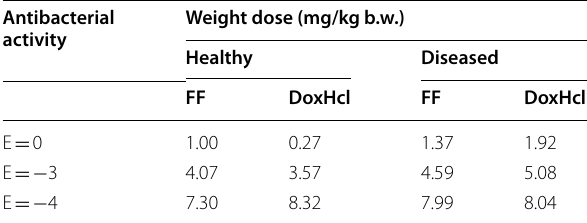
E 0, 3, 4, respectively represent the target values of AUC 24h /MIC under the = − − targets of antibacterial, therapeutic and eradication